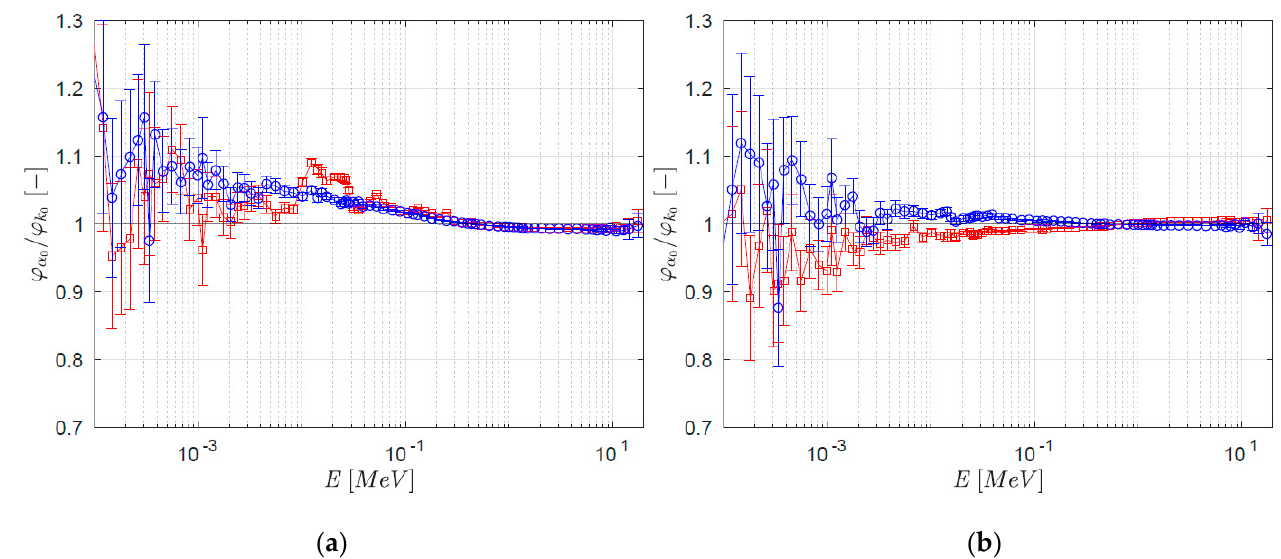
Figure 3. Problem I, ratios ϕ α / ϕ k 0 of the direct fundamental distributions, for sub-critical ( a ) and super-critical ( b ) configuration, with (red squares) and without (blue circles) delayed contributions.